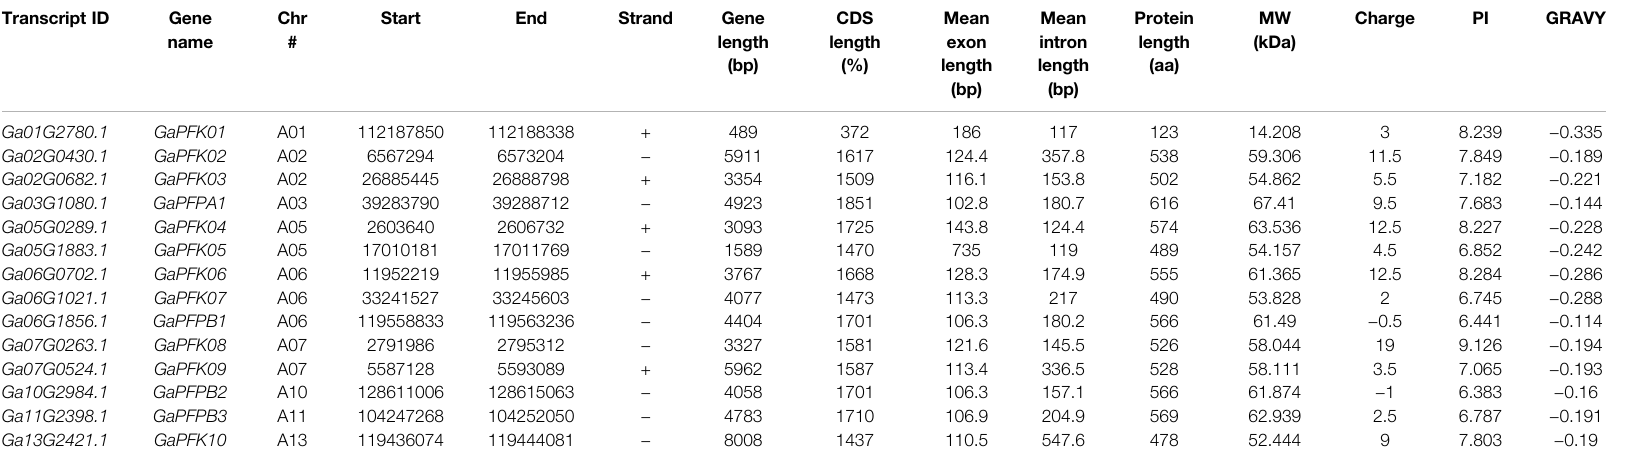
TABLE 2 | Transcript and physiochemical features of PFK genes in G. arboreum .